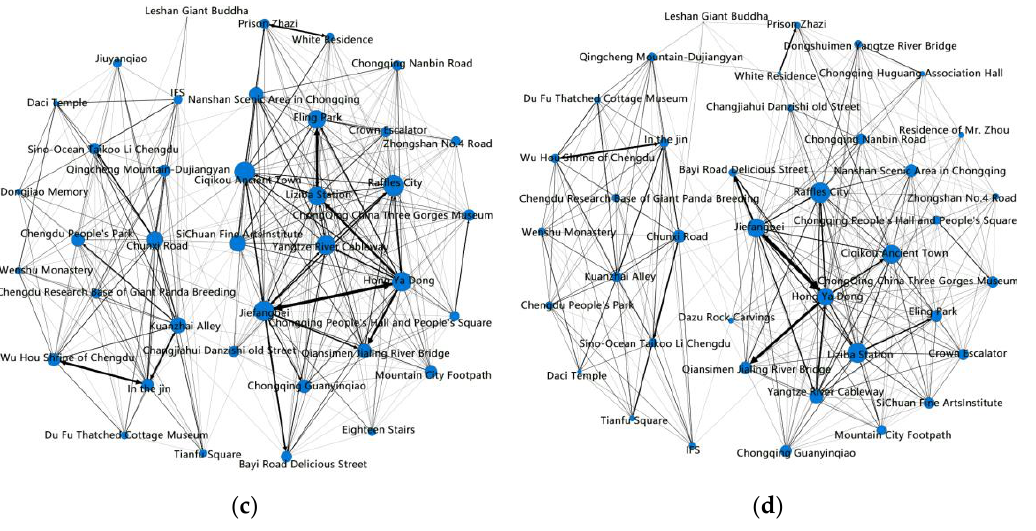
Figure 2. ( a ) Tourism flow network diagram 2018; ( b ) tourism flow network diagram 2019; ( c ) tourism flow network diagram 2020; ( d ) tourism flow network diagram 2021.